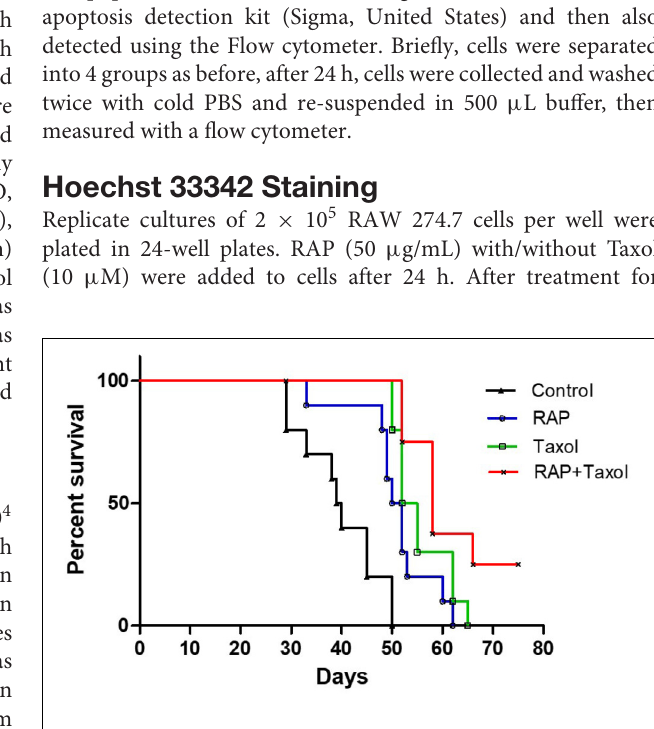
Frontiers in Pharmacology |